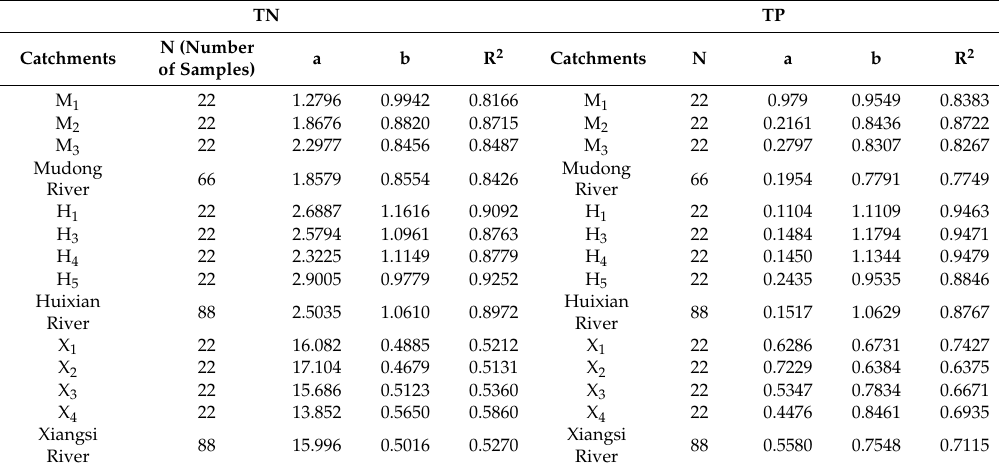
Table 4. Regression analysis results for discharge as a function of TN and TP fluxes at the 11 catchment